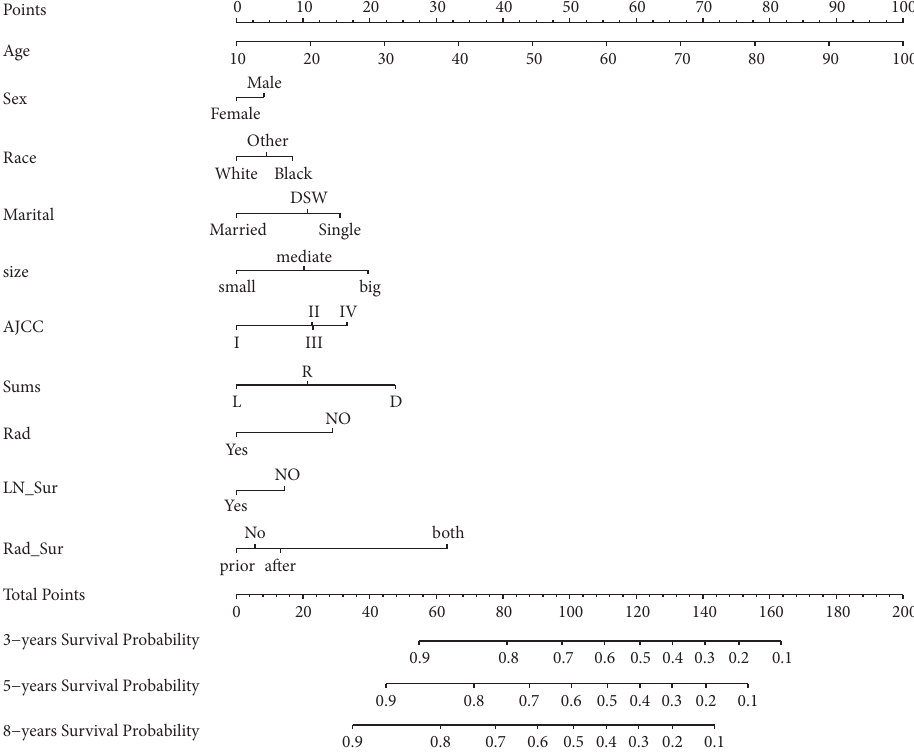
Figure 2: Nomogram predicting 3-, 5-, and 8-year OS probability. Sums: SEER summary stage; rad: radiotherapy status; chemo: che- motherapy status; LN_sur: regional lymph node dissection after surgery; rad_sur: sequence of